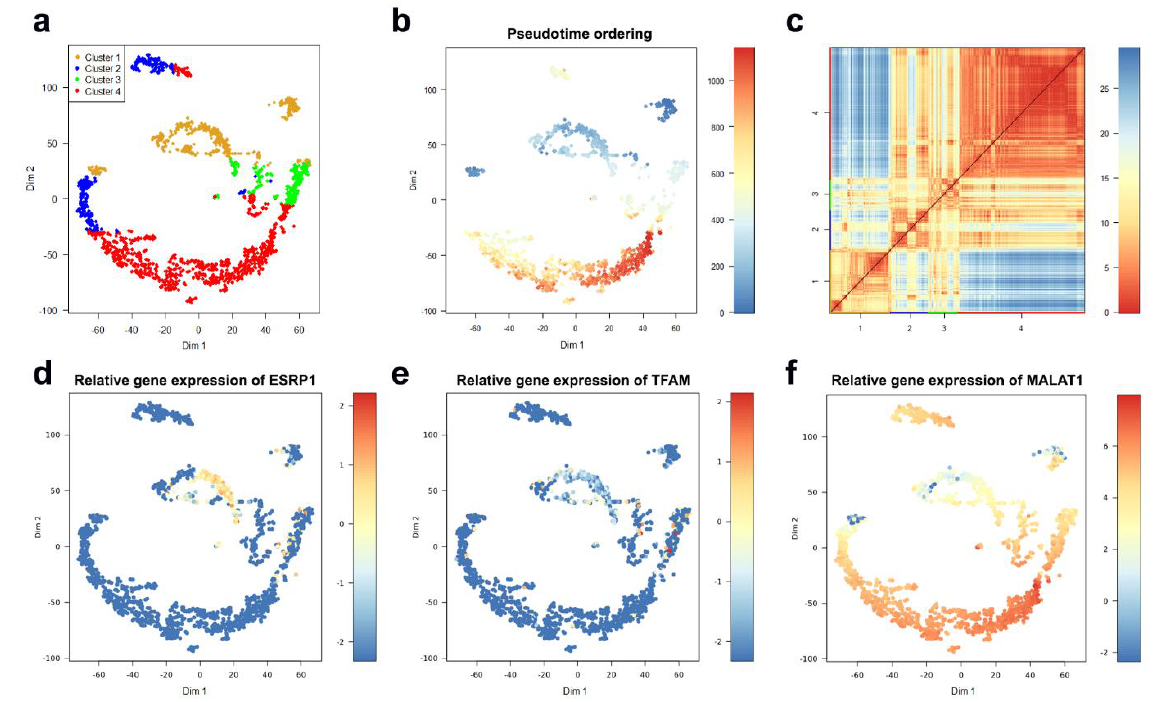
Figure 2. Identification of the circulating tumor cell (CTC) sub-populations, clustered based on the median expression of all genes in at least 10% of the cells. ( a ) t SNE map visualizing clusters of circulating breast cancer cells identified with k-means clustering. ( b ) The plot from ( a ) with cells colored based on their pseudo-time ordering. ( c ) A heatmap portrayal of cell-to-cell distances; cluster centers were ordered by hierarchic clustering. ( d ) The plot from ( a ) with cells colored based on their ESRP1 expression. ( e ) The plot from ( a ) with cells colored based on their TFAM expression. ( f ) The plot from ( a ) with cells colored based on their MALAT1 expression.